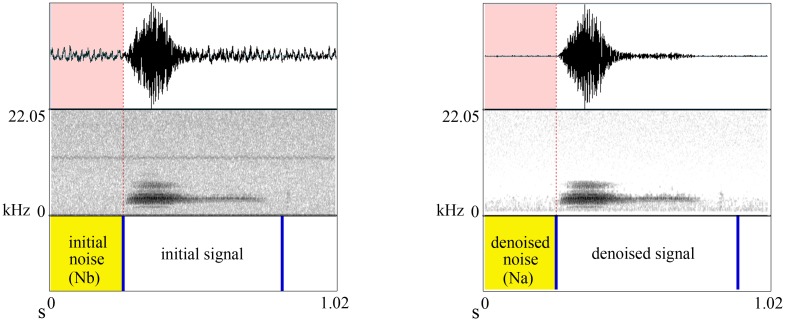
An example of kakapo chinging used in the experiment.Top, middle, and last rows represent oscillogram, spectrogram, and labels indicating the parts of the recording used to calculate the SnNR respectively. (a) Initial signal and (b) the same signal after denoising and band-pass filtering.